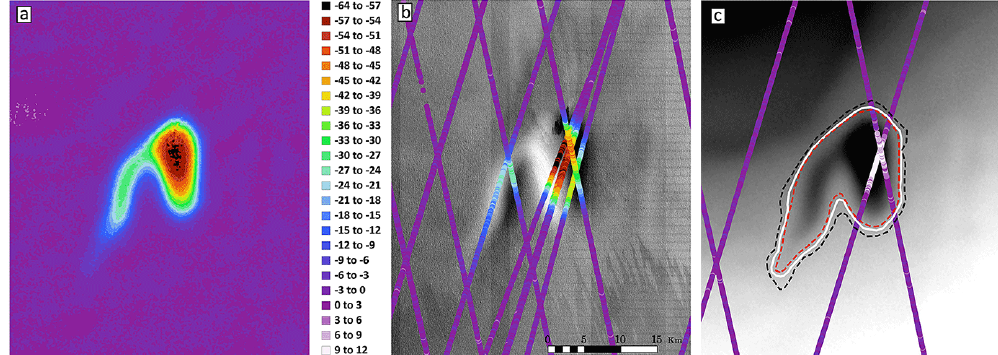
Fig. 4. Surface elevation changes (m) for Lake Cook E2 from ICESat, SPOT5 and ASTER DEMs. Negative values correspond to surface lowering. Elevation changes on all panels share the same colour scale. (a) Map of elevation differences between the post- and pre-drainage DEMs. (b) Elevation difference between the 9 February 2012 SPOT5 DEM and ICESat laser periods 2A, 3B and 3C, all acquired prior to the lake drainage. These laser periods were selected to illustrate the evolving spatial sampling of the surface lowering that can be obtained from different laser periods. Note that only laser period 2A crosses the secondary lake. Background: the SPOT5 image from 9 February 2012 (copyright: CNES 2012, distribution Spot Image). (c) Elevation difference between the 9 February 2012 SPOT5 DEM and ICESat laser periods 2E, acquired in March 2009, a few months after the end of the lake drainage. The black, white, and red lines show the rim around the depression represent elevation difference thresholds of − 1.5, − 3, and − 4.5m, respectively. The corresponding “lake area” is, respectively, 267km 2 , 219km 2 and 192km 2 . This panel shows the approximately 10–15m rise of the surface above Lake Cook E2 during the 4years following the drainage. Background: the 9 February 2012 SPOT5 DEM.